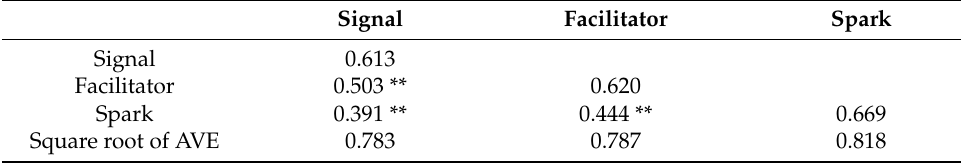
Table 11. Discriminant Validity of the Latent Variables.